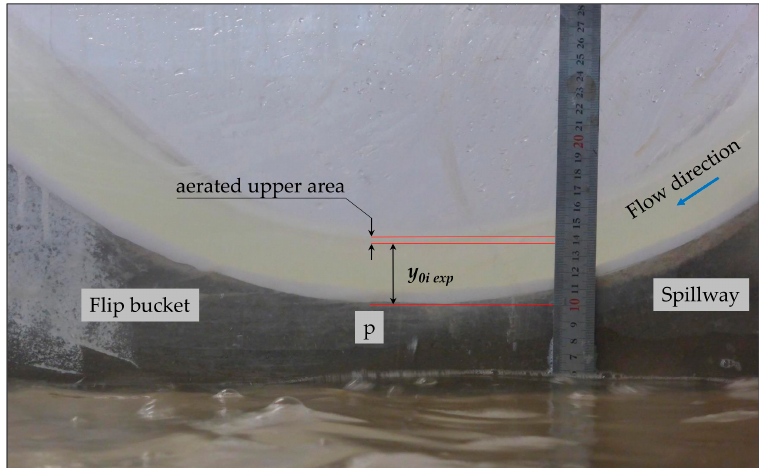
Figure 8. Flow at the lower part of the flip-bucket for case C2, with a discharge of 43.56 L / s. The upper part of the flow is intensely aerated. The lowest point of the flip bucket is “p” and the flow depth without intensely aerated upper area is y 0 i exp .